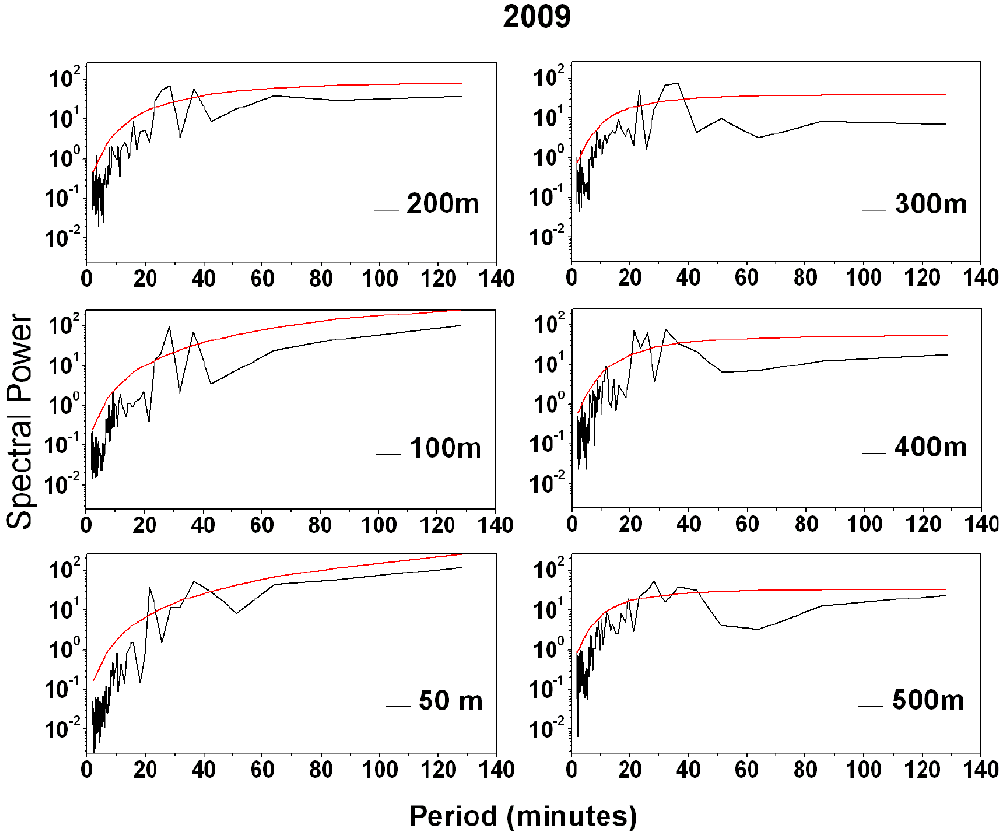
Fig. 8. Same as Fig. 6 but for all the experimental days in